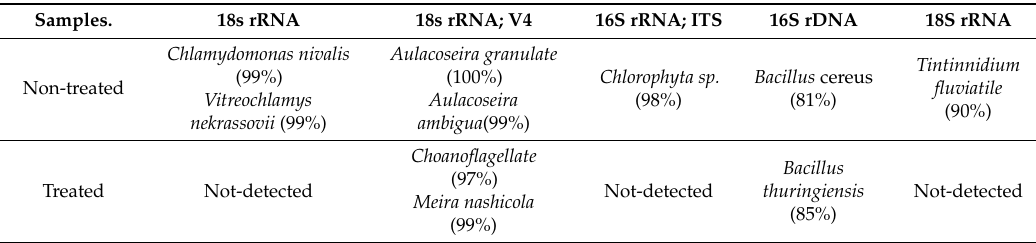
Table 4. The summary of detected dominant signal information based on the direct capillary sequencing and cloning (identity